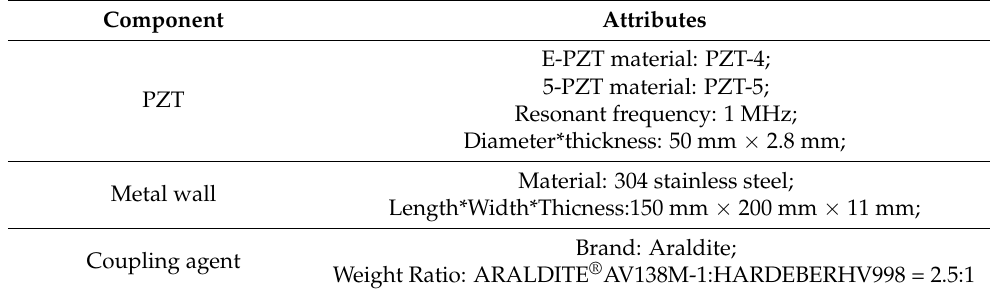
Table 1. Properties of acoustic-electrical channel